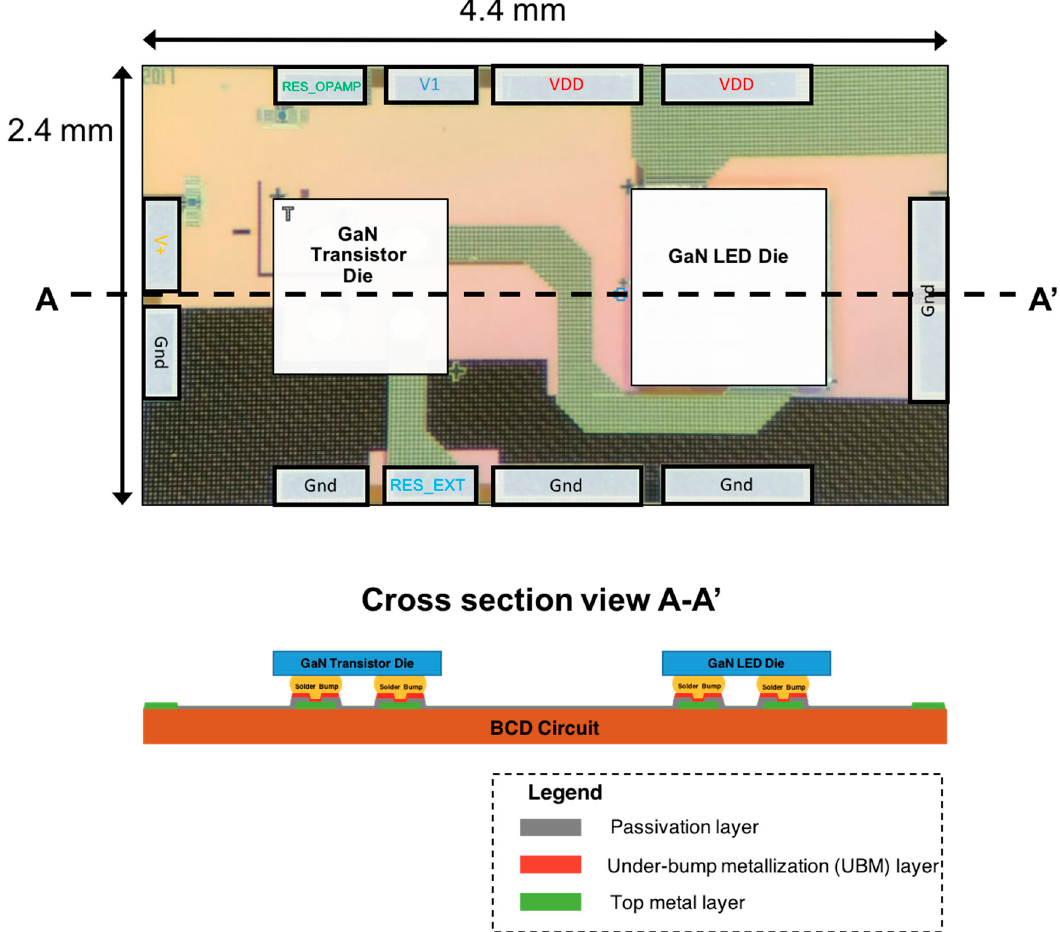
Figure 2. Microchip snapshot indicating bond pad layouts for GaN LED and GaN transistor to the bipolar CMOS DMOS (BCD) LED driver circuit with the cross-section sketch view of the GaN2BCD TM technology.